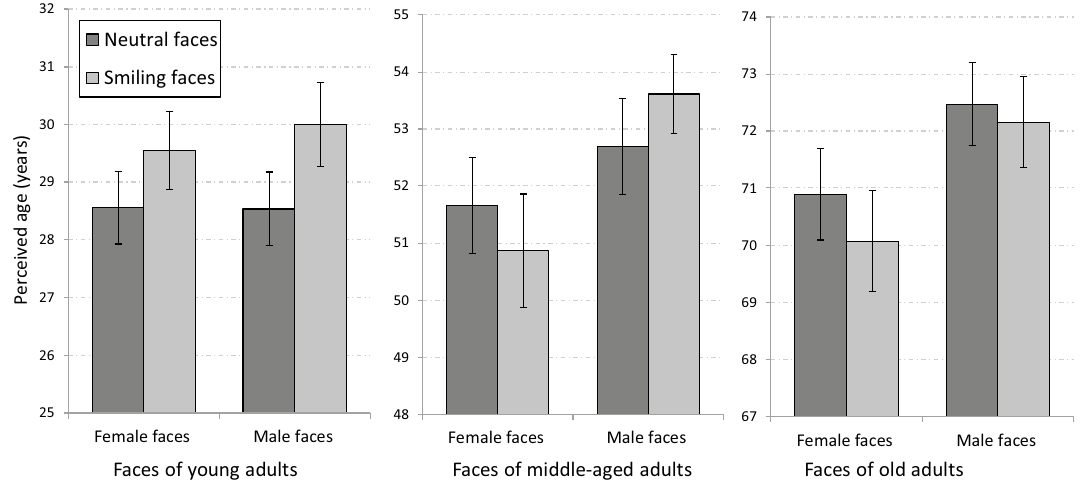
Figure 5. The aging effect of smiling (AES) in different age groups of faces in Experiment 3 (full faces). Participants were middle-aged adults. Note, that as in Experiment 1a, for faces of middle-aged adults,